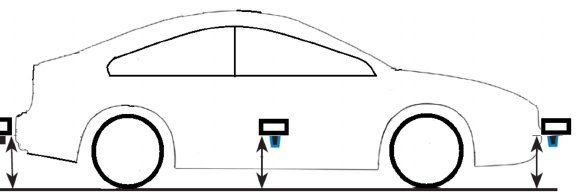
Figure 13. Distribution of sensors in a sedan car according to [58]. In this proposal, the plan is to follow that rule for the front detector in the automated